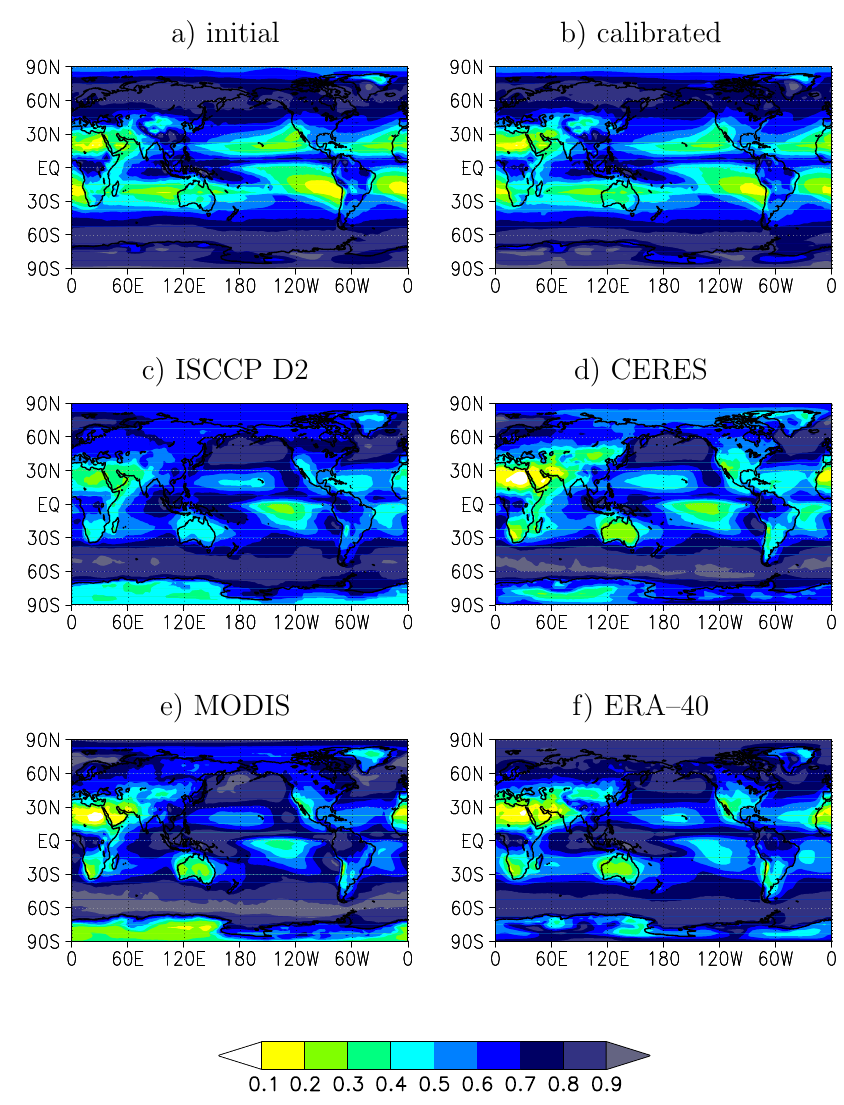
Fig. 2. Annual mean modelled total cloud fraction (fractions) for initial and calibrated parameter sets ( a and b , respectively) in comparison to the ISCCP D2, CERES, MODIS, and ERA-40 climatologies ( c , d , e , and f respectively).